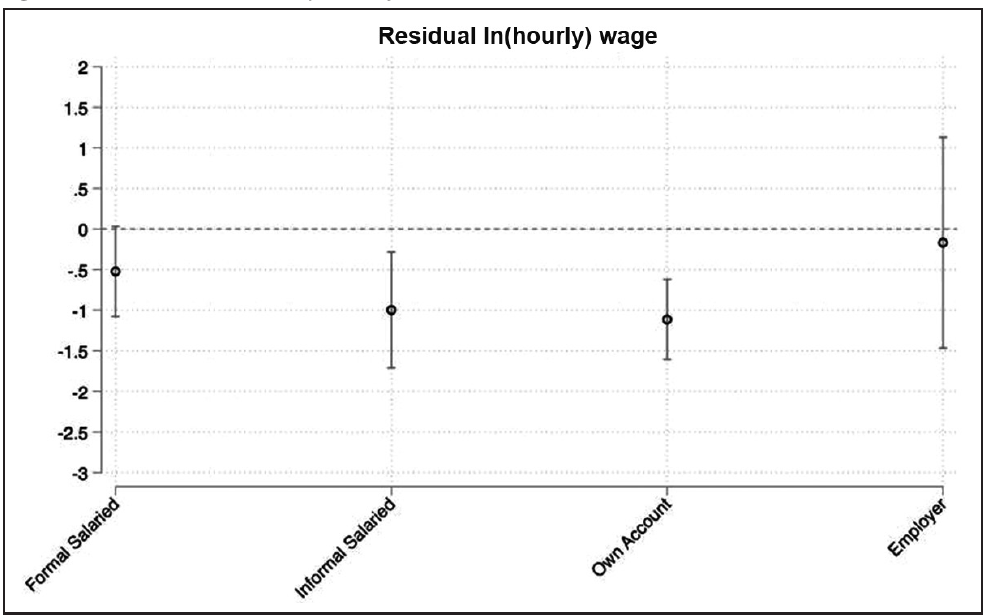
Figure A5 2SLS coefficient plot – by work sector.